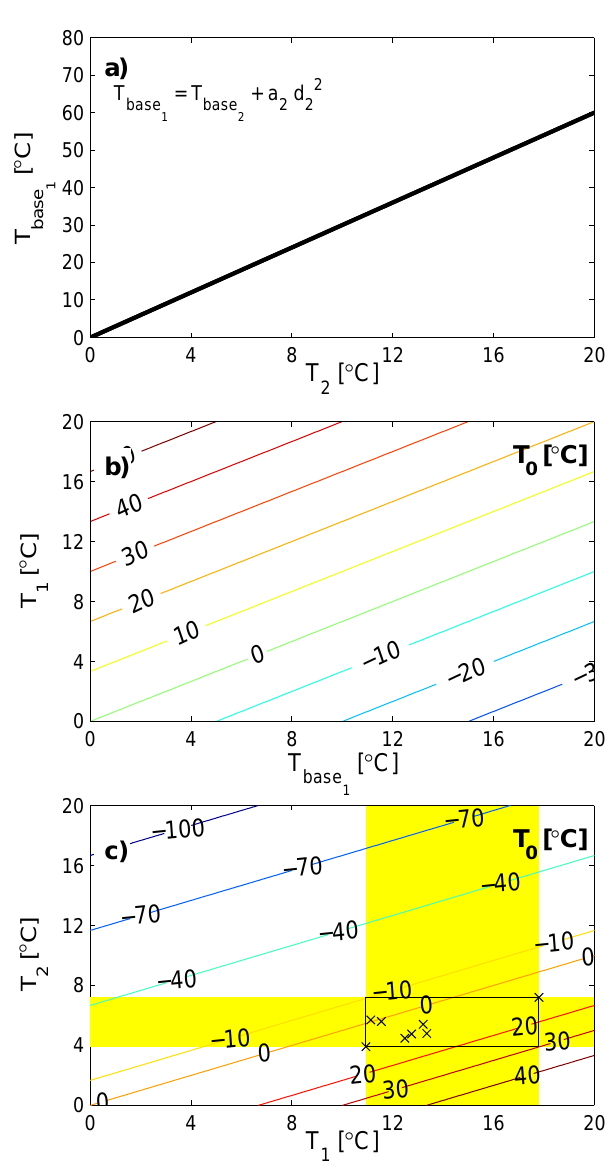
Fig. 5. Dependency of soil temperature parameters: (a) relation- ship between mean temperature of layer 2 ( ¯ T 2 ) and bottom tem- perature of layer 1 [ T base , Eq. (7)] – a 2 is calculated according 1 to Eq. (6); (b) surface temperature ( T 0 ) contour plot as function of T base and layer 1 mean temperature ( ¯ T 1 ) and (c) contours of ( T 0 ) as 1 function of ¯ T 2 and ¯ T 1 . The black rectangle at the intersection of the layer temperature ranges (yellow) indicates the theoretical parame- ter space given by the temperature values used in this study and the black crosses mark the actual